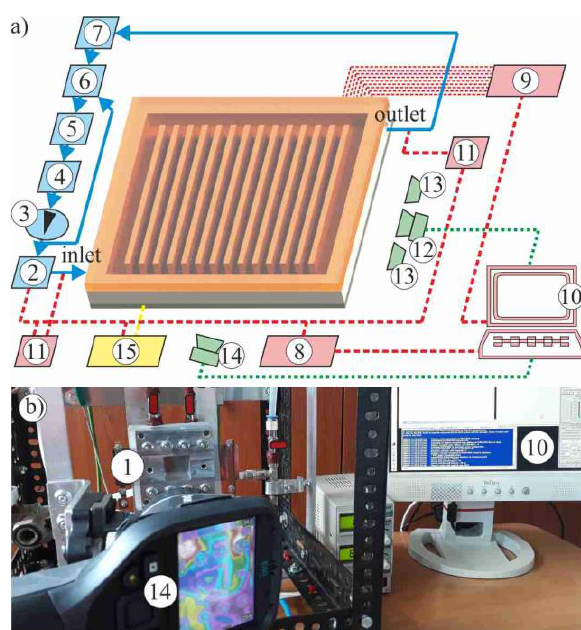
Fig. 2. The new experimental stand with a test section with a group of rectangular mini- or microchannels (a heat sink):